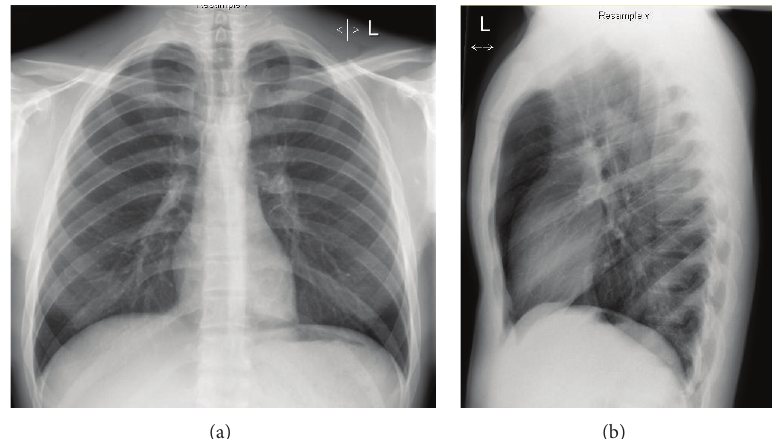
Figure 3: Chest X-ray showing complete resolution of findings compared to Figures 1(a) and